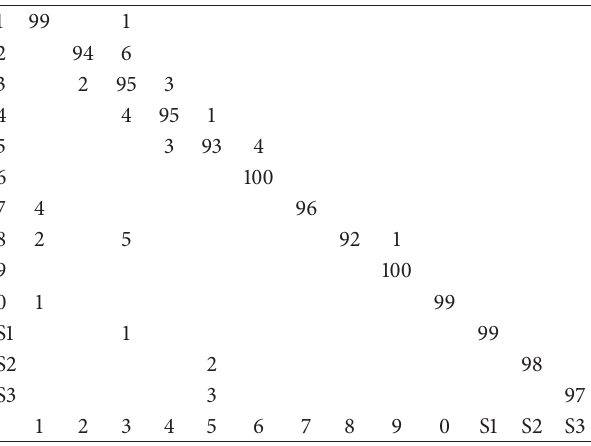
Table 1: The confusion matrix of hand gesture recognition on data set